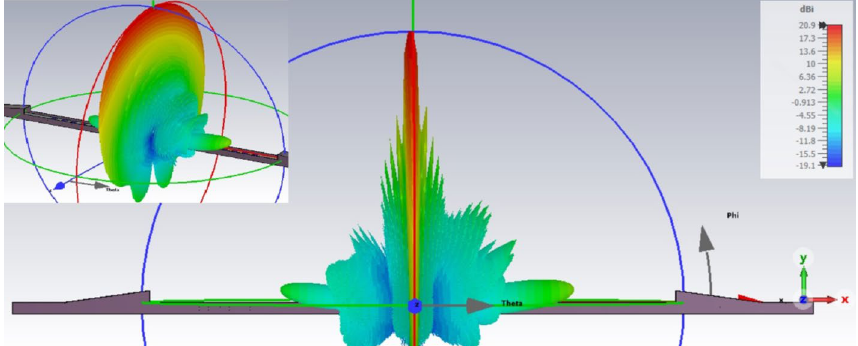
Fig. 8 3D radiation pattern at frequency F = 37.2 GHz (RP: 20.9 dBi, width of RP: 2.8 ◦ , side lope: − 10.5 dB) for antenna with identical